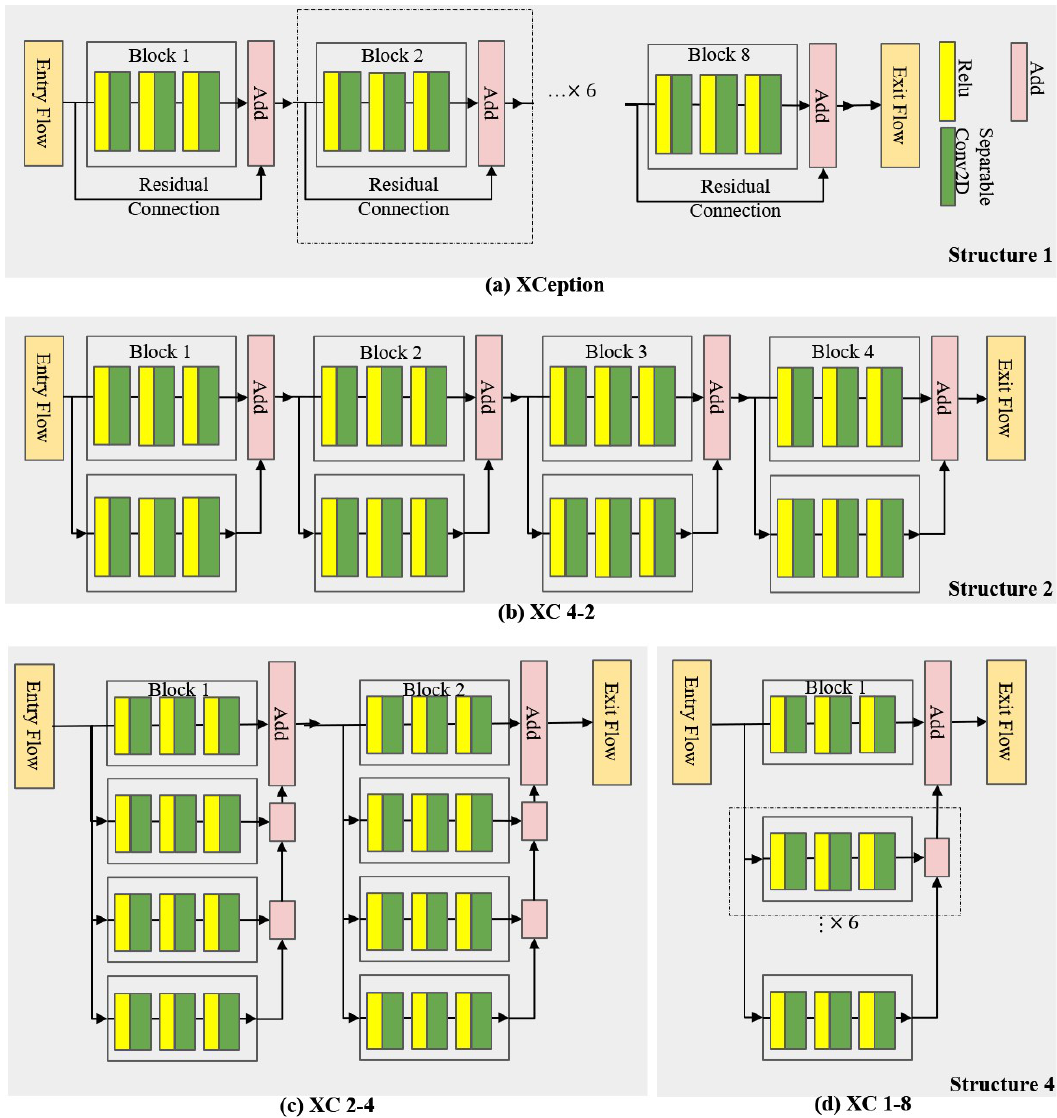
Figure 3. Xcption and 3 branch expansion networks. Note that each separable convolution layer is followed by batch normalization (not marked in the figure). ( a ) Xception. ( b – d ) Branch extension networks with different depths and widths after core structure recombination, respectively, denoted as “XC Depth-Width”. The depth and width here represent the number of the stacked block and the parallel branches in each block,